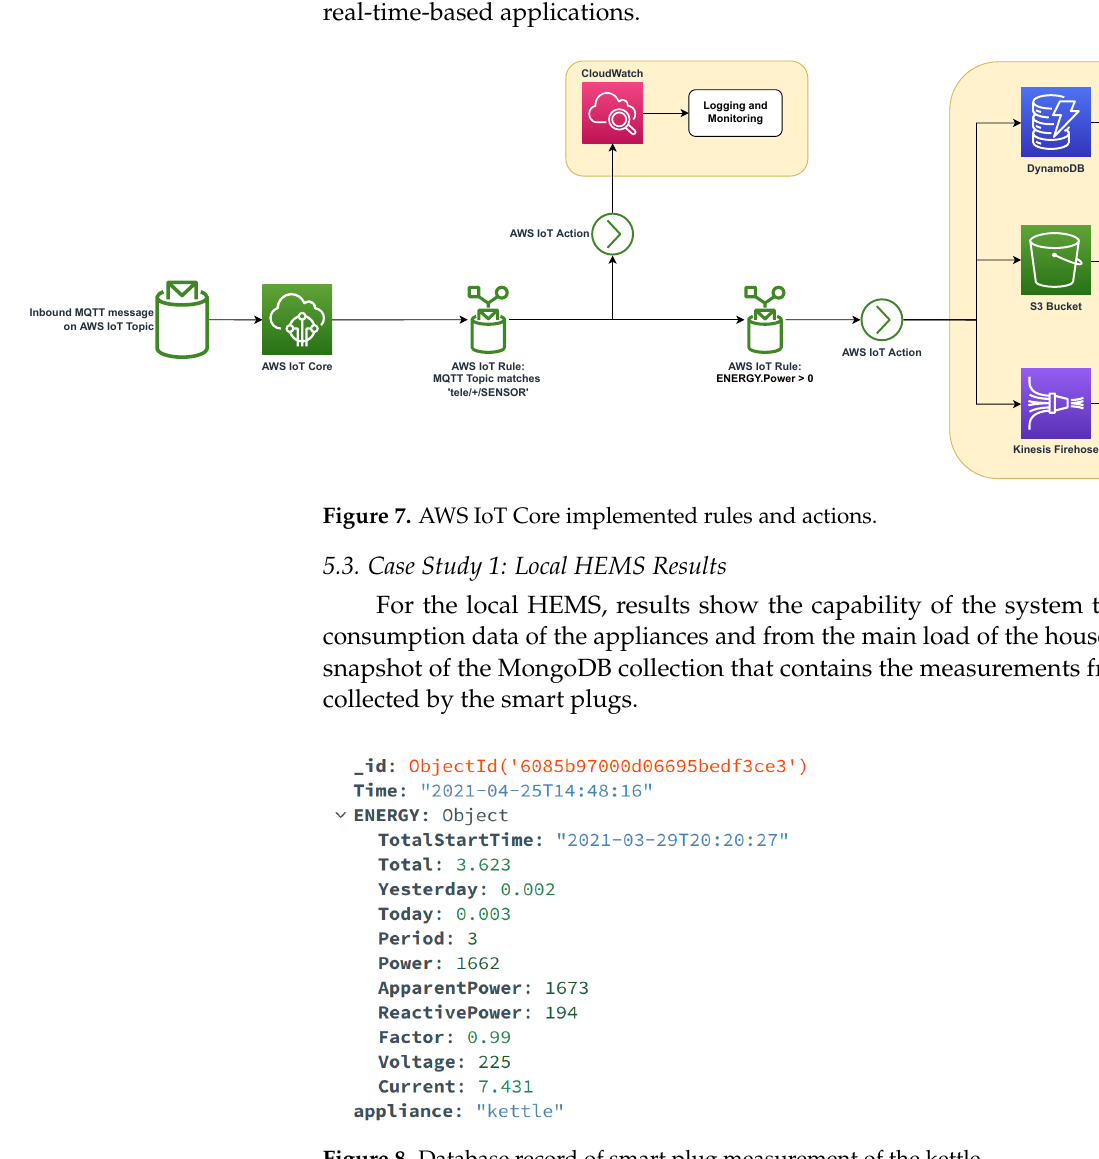
Figure 8. Database record of smart plug measurement of the